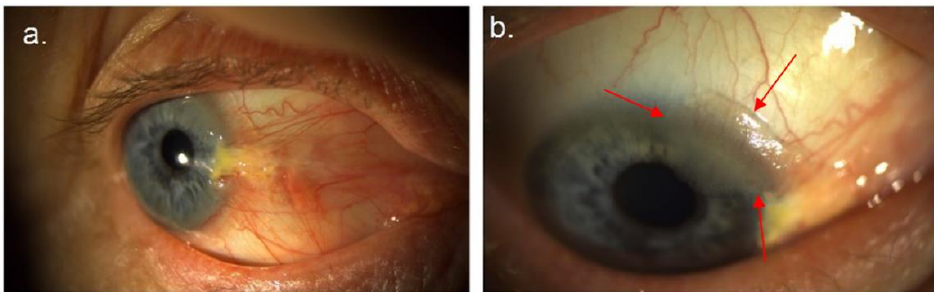
Figure 1. ( a ) Right nasal pterygium with atypical changes at the superior margin. ( b ) Gelatinous lesion (arrows) contiguous with and arising in the super-limbal aspect of the pterygium — confirmed as OSSN by biopsy.